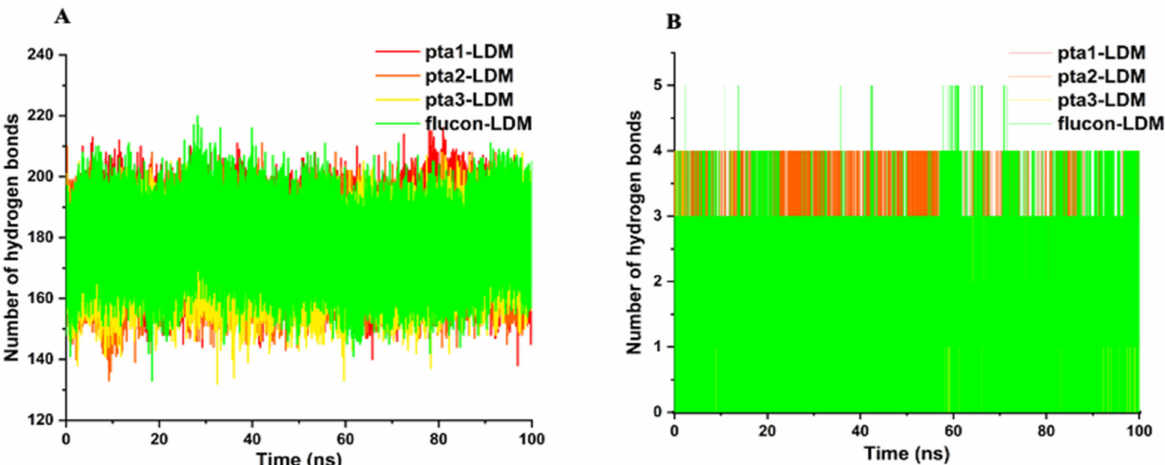
Figure 4. Hydrogen bond analysis. ( A ) Intramolecular hydrogen bonds in pta1, pta2, pta3, and fluconazole-LDM complexes. ( B ) Intermolecular hydrogen bonds in pta1, pta2, pta3, and fluconazole bound LMD complexes calculated after 100 ns MD simulation.